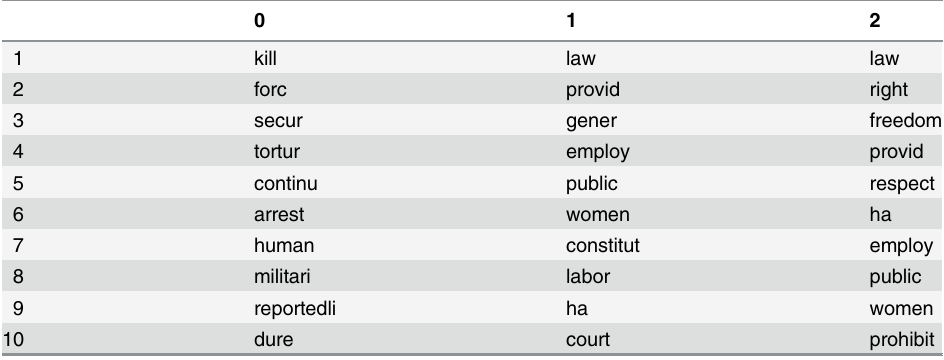
Table 5. Ten most important words for the CIRI Torture variable.